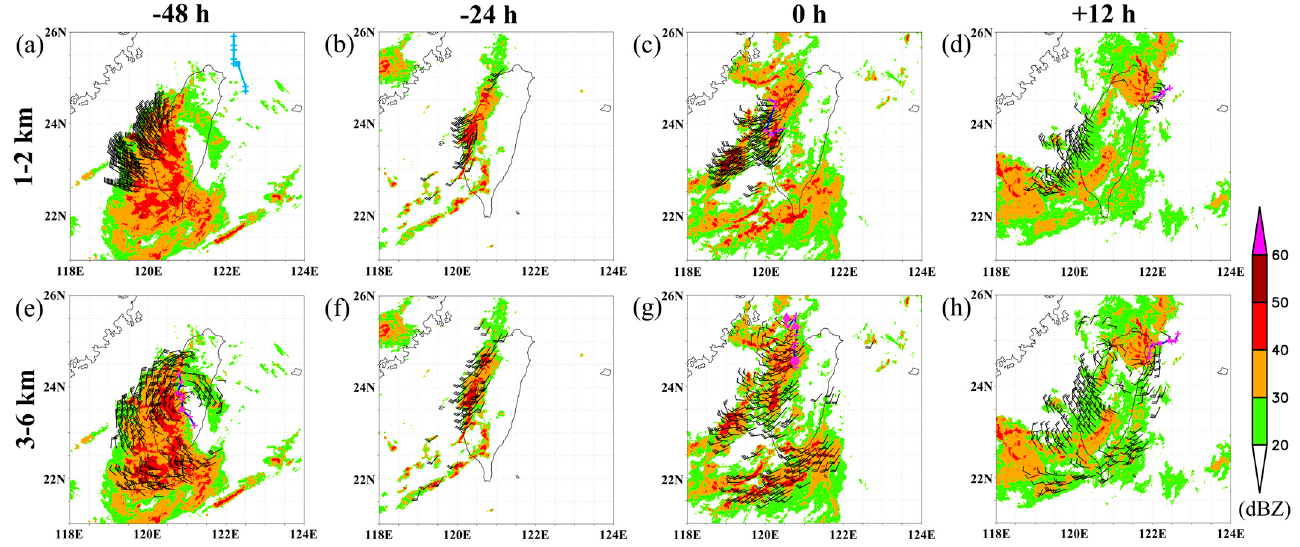
Figure 4. Radar reflectivity (shading; dBZ) and dual-Doppler wind (barbs; kts) on level ( a – d ) 1–2 km and ( e – h ) 3–6 km, at ( a , e ) 0000 UTC 29 August, ( b , f ) 0000 UTC 30 August, ( c , g ) 0000 UTC 31 August, ( d , h ) 1200 UTC 31 August. The blue tracks indicate the center of ( a – d ) low-level and ( e – h ) mid-level vortex center according to the CWB observation (cyan curves and signs) and the dual-Doppler wind (blue curves & magenta signs) (1–2 km averaged wind for low-level vortex; 3–6 km averaged wind for mid-level vortex). Square signs denote 0000 UTC 29 August; diamond signs denote 0000 UTC 31 August; triangle signs denote 0600 UTC 31 August; circle signs denote 1200 UTC 31 August; reversed triangle signs denote 1800 UTC 31 August; cross signs denote 1-h time